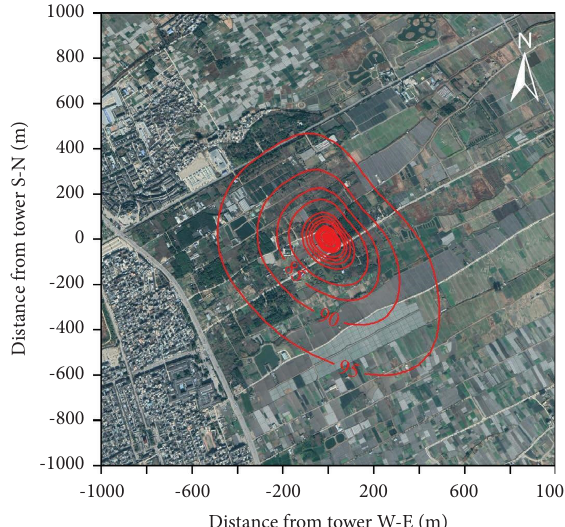
Figure 2: Average footprint source at Dali fux station from 2007 to 2018. Te cumulative footprint contours were superimposed on the map from Google Earth and the maximum footprint contour line is shown with Table 1: Instrumentations, measurement heights, sampling rate, sensors, and manufacturers of the Dali fux station. Instruments